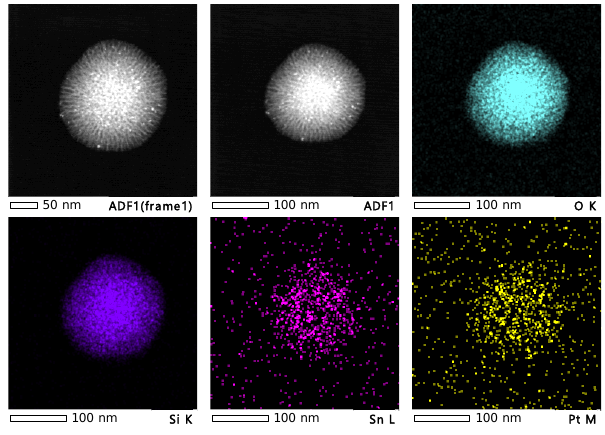
Figure 7. HRTEM images and EDS elemental mapping of spent Pt 1 Sn 2 /DMSN catalyst.